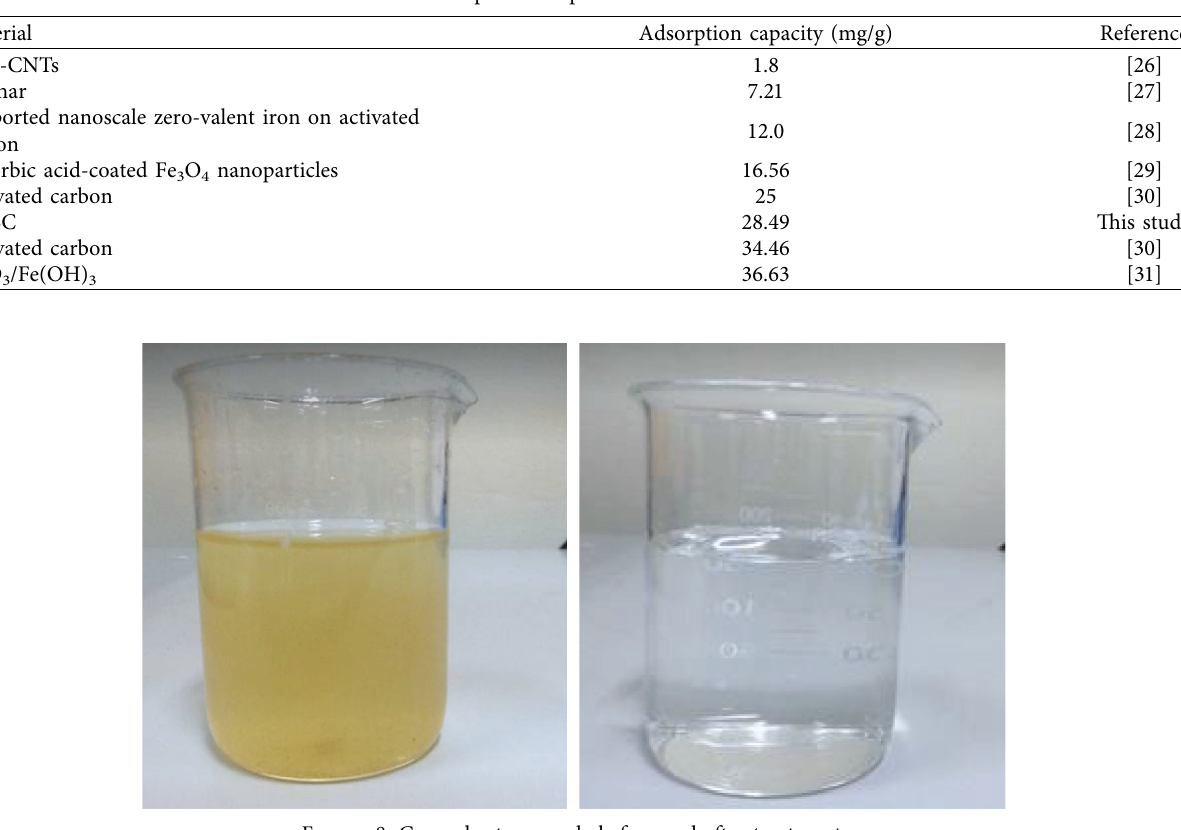
Table 2: Adsorption comparison with other studies.